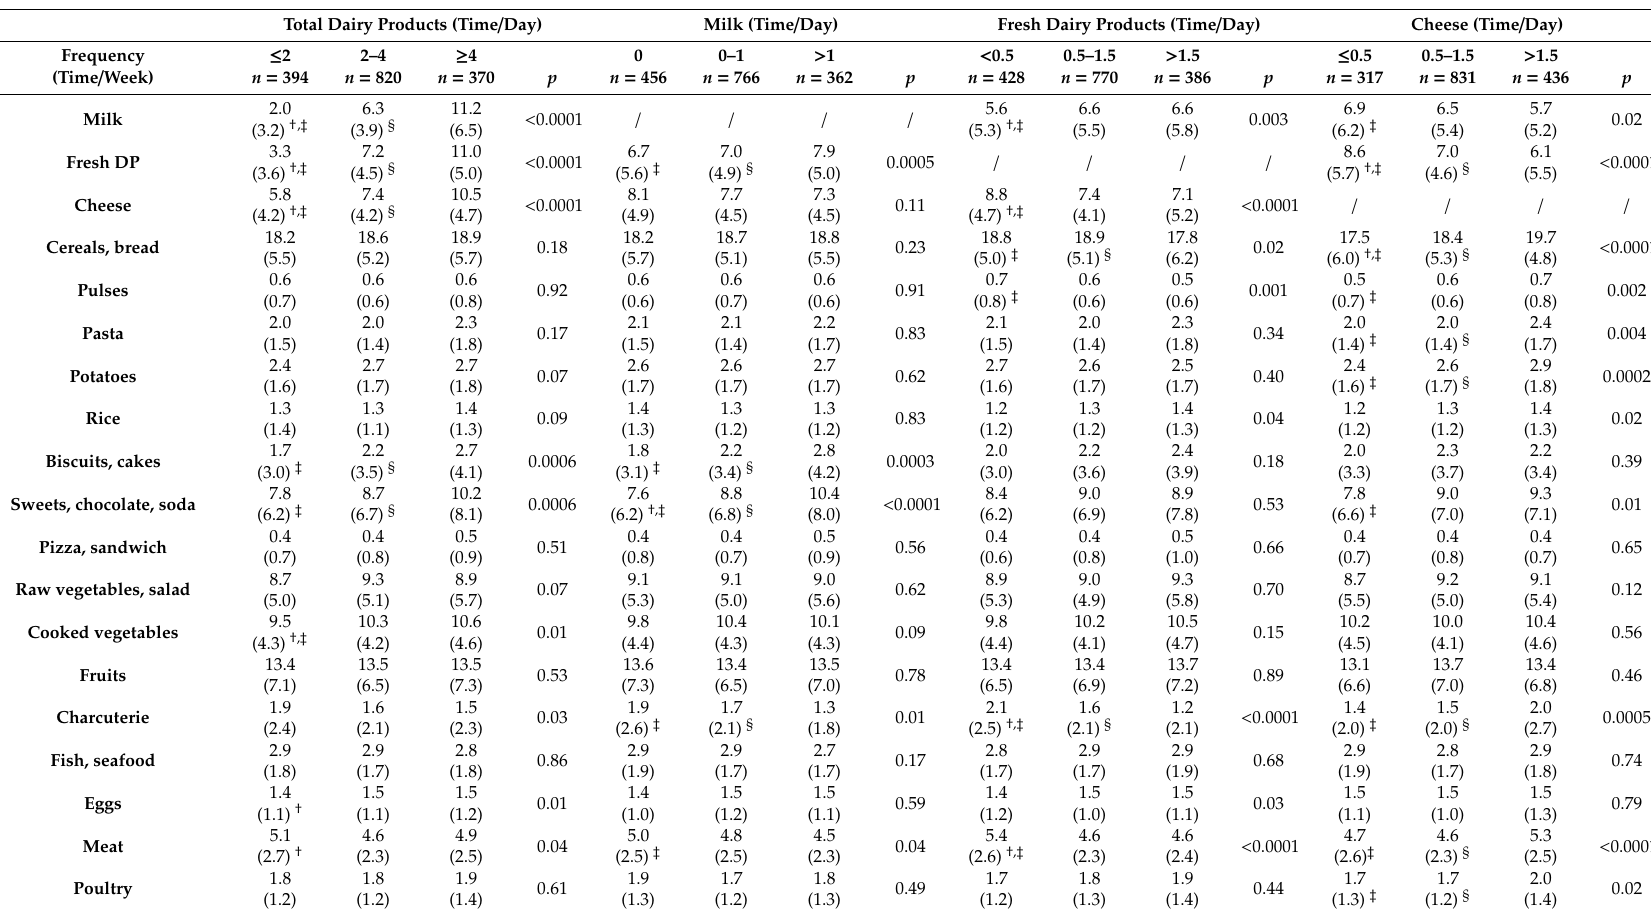
Table 3. Mean weekly food groups’ frequency consumption based on the daily frequency consumption of total dairy products and dairy product subtypes among elderly community dwellers from the 3C study, Bordeaux (France), 2001–2002, n =